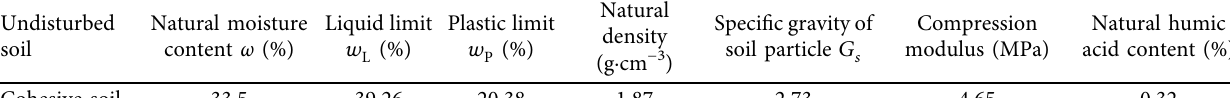
Table 1: Physical and mechanical properties index of undisturbed soil for a test. Undisturbed